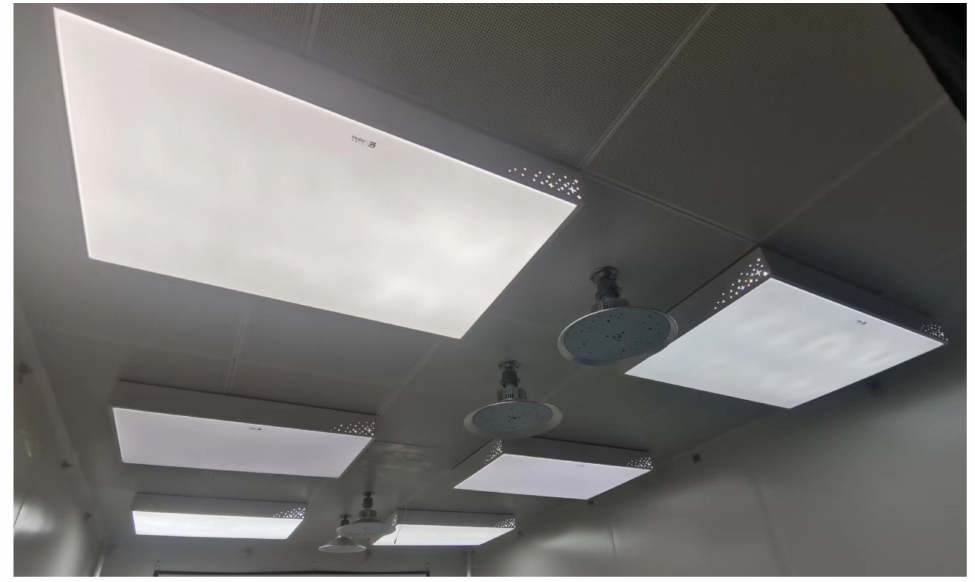
Figure 2. Layout of